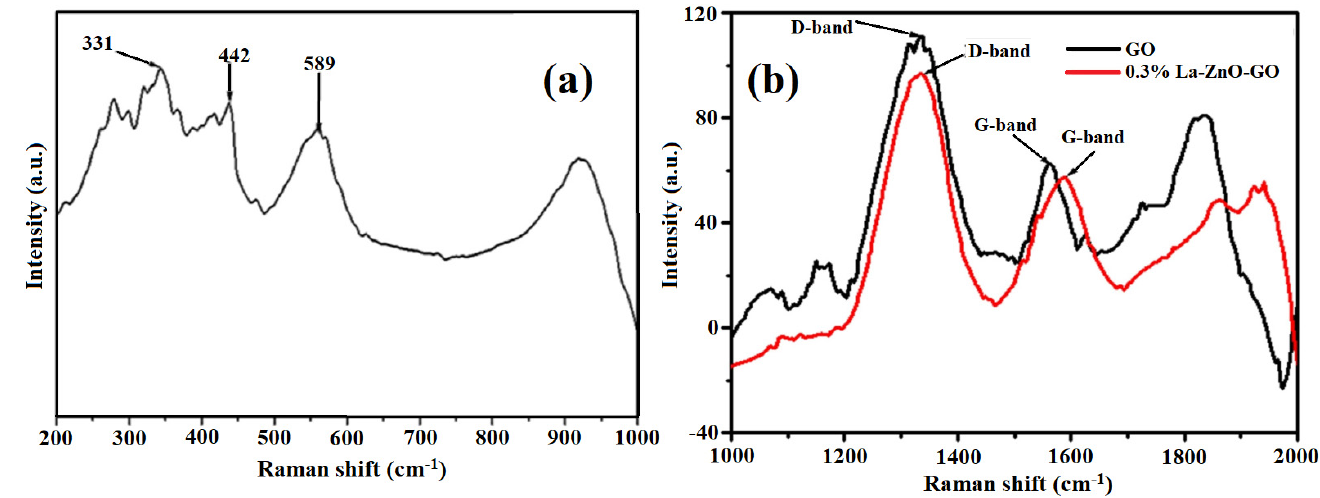
Figure 12. Raman spectra of ( a ) zinc oxide and ( b ) graphene oxide and 0.3% lanthanum-doped zinc oxide-graphene oxide [75].